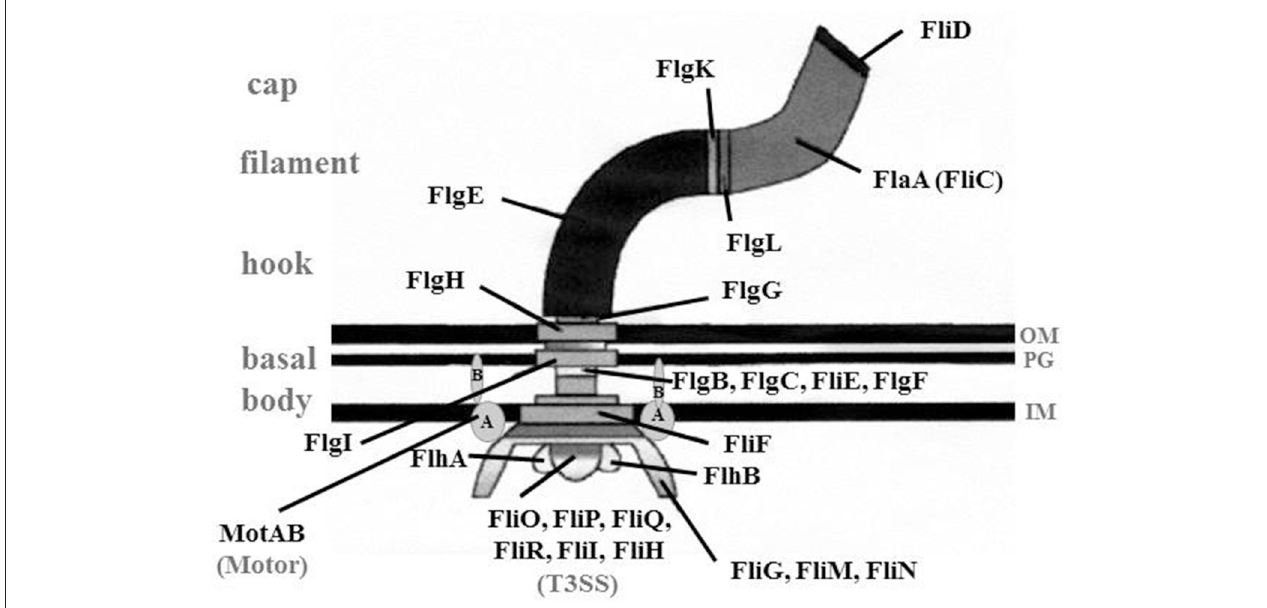
FIGURE 2 | Overview of the structure of a flagellum. Schematic drawing of a flagellum consisting of basal body, hook structure and filament. Cap, FliD protein that is essential for the assembly of the filament, Motor, MotAB proteins that provide energy for the rotation; T3SS, type III-like secretion system; FlgD (not shown), the hook cap protein needed to incorporate FlgE; IM, inner membrane; OM, outer membrane; PG, peptidoglycan layer; ( Heuner and Albert-Weissenberger (2008),